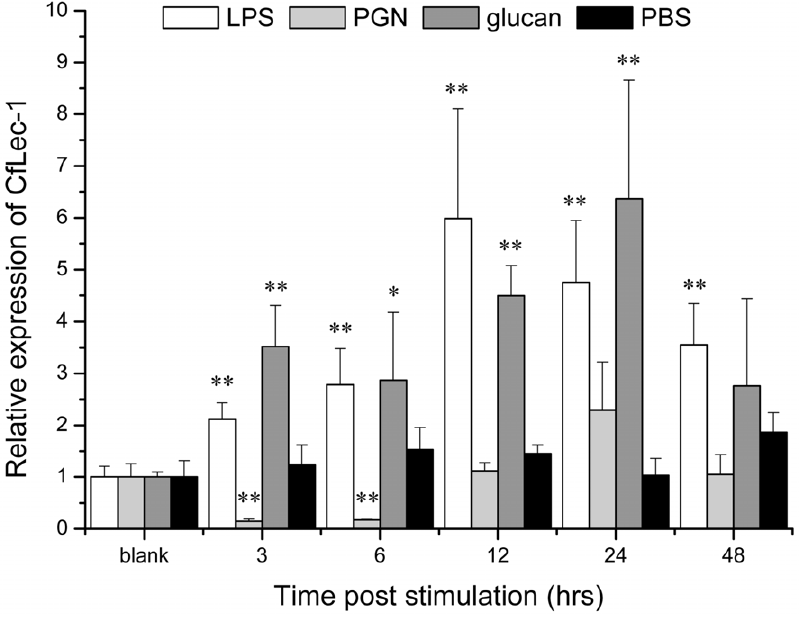
Figure 1. Temporal expression of CfLec-1 mRNA relative to b -actin was analyzed by realtime PCR in scallop hemocytes after LPS, PGN, b -glucan and PBS challenge for 3, 6, 12, 24 and 48 h. The values are shown as mean 6 SE (N=4). (*: P , 0.05, **: P ,